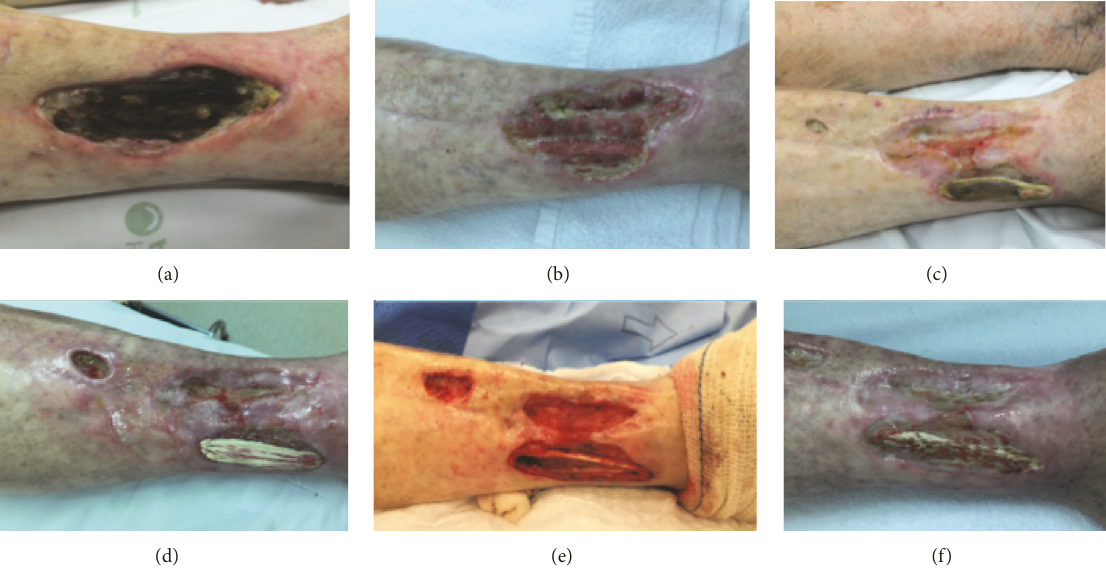
Figure 4: (a) Radionecrosis in right leg, clinical aspect before first surgery; ((b) and (c)) there was no granulation in the area of exposed and necrotic tendon, which led to ((d) and (e)) debridement and removal of necrotic tendon. This was the third time that Matriderm was placed; (f) clinical aspect, waiting for skin